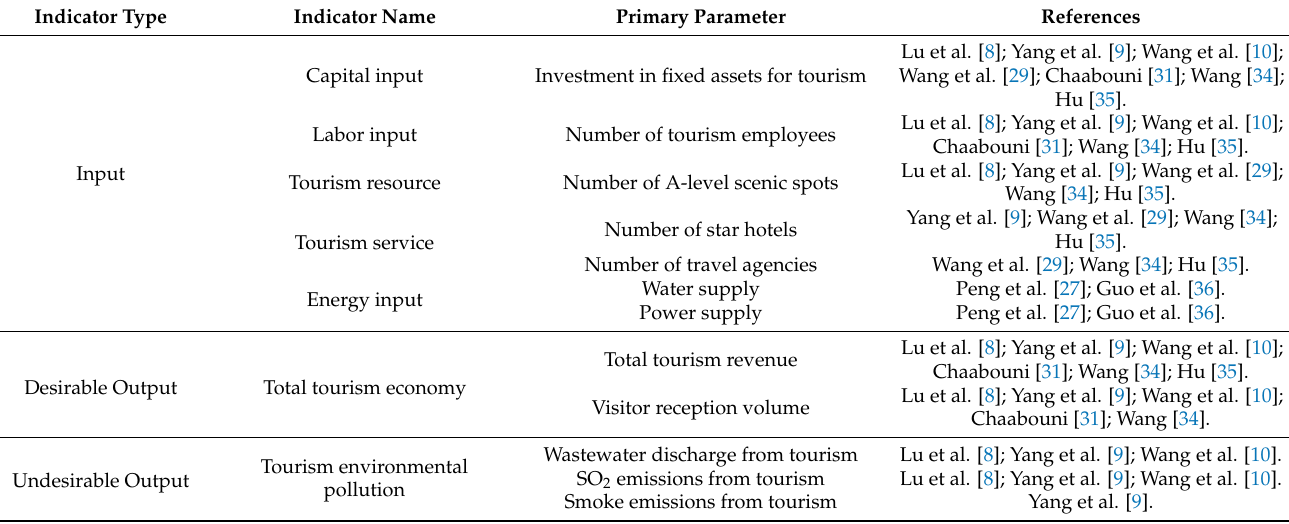
Table 1. Tourism eco-efficiency evaluation